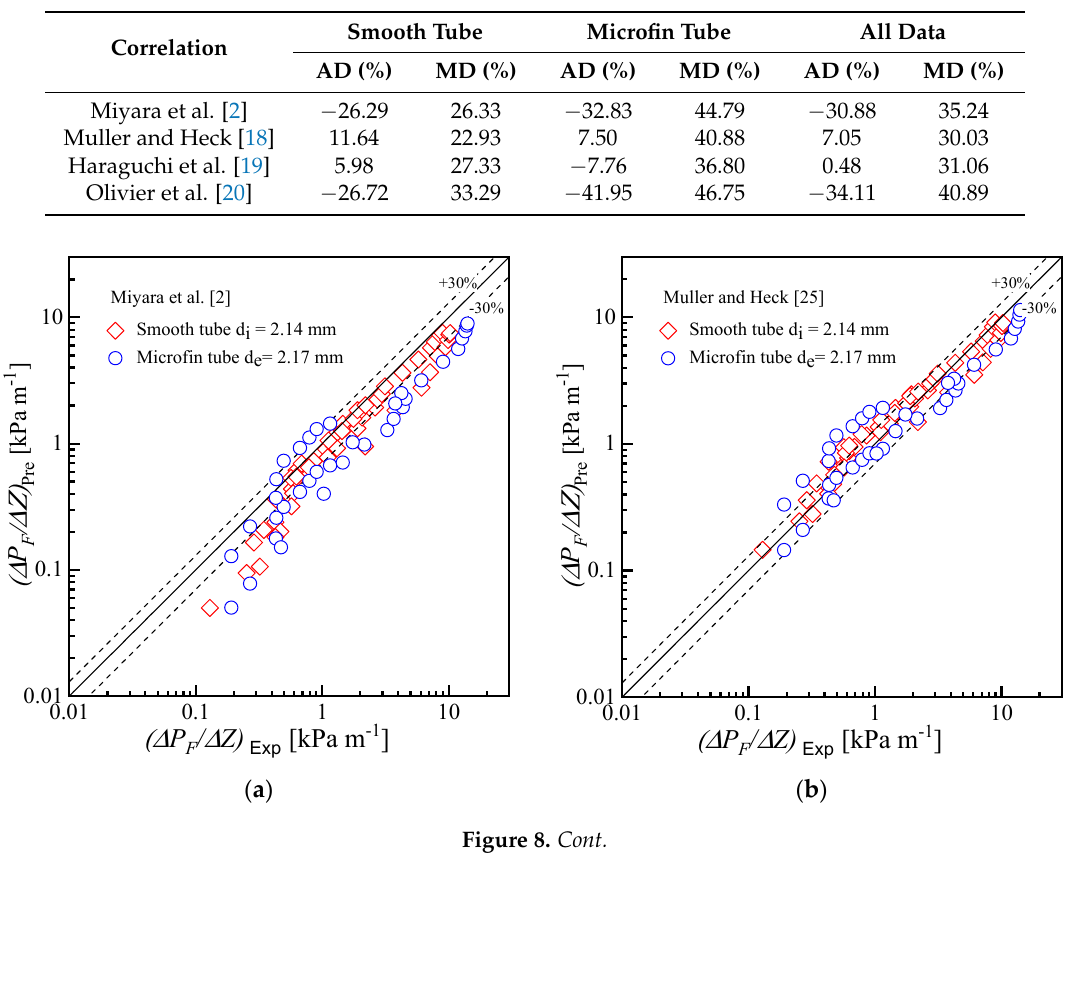
Table 4. Deviations of frictional pressure drop. AD: average deviation; MD: mean deviation.